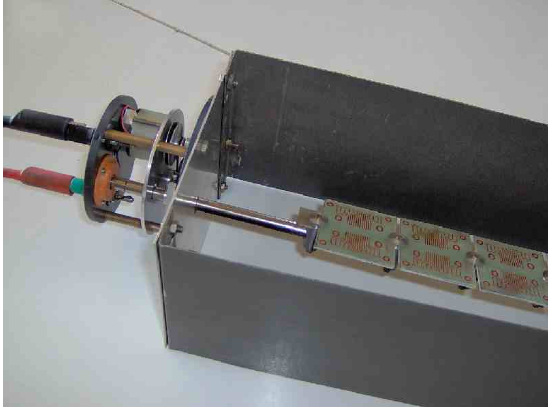
Figure 2. Equipment for tilting at temperature.